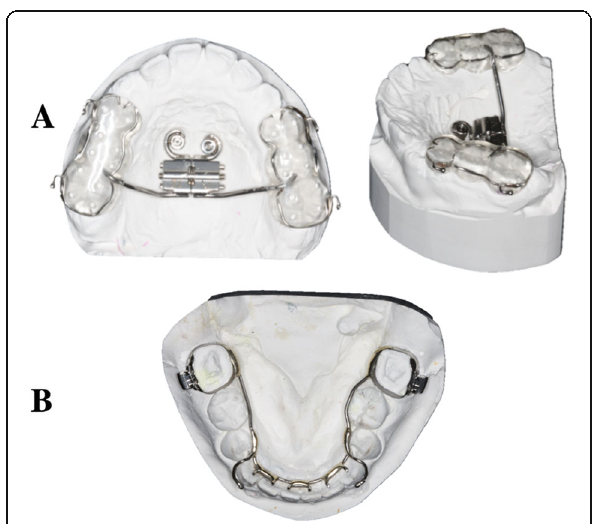
Fig. 2 a Hybrid MARPE and b MLA appliance